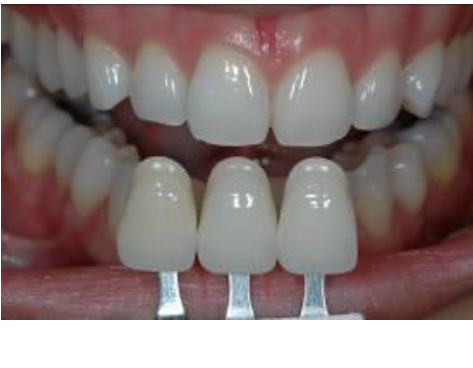
Figure 2. Visual shade matching of the three visually closest shade tabs of a commercially available shade guide against the upper right central